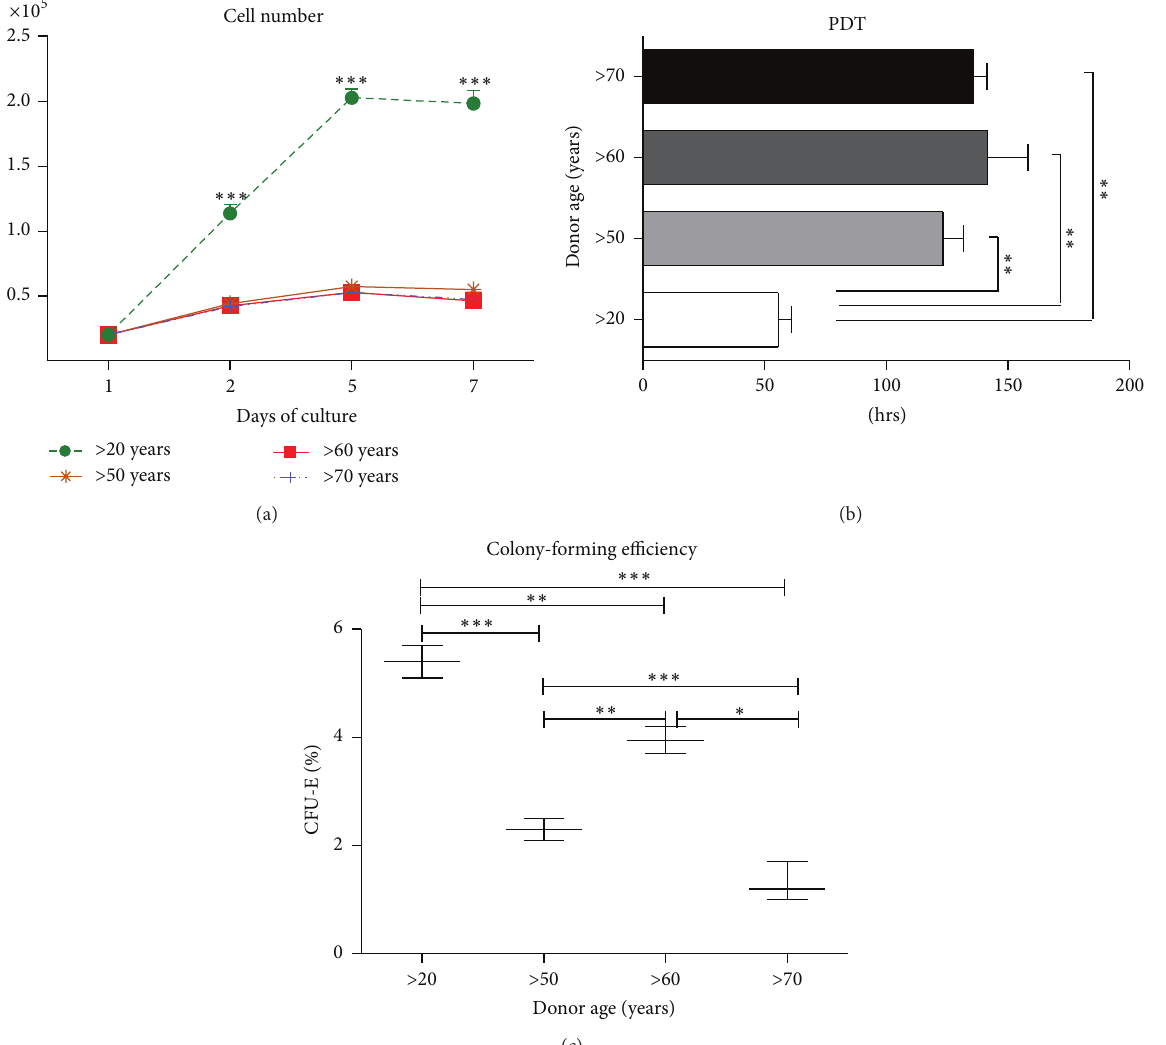
Figure 3: Comparison of cell proliferation in different age groups. (a) Cell proliferation assay, (b) population doubling time, and (c) fibroblast colony-forming unit efficiency over seven days. Results expressed as mean ± SD. ∗ 𝑝 value <